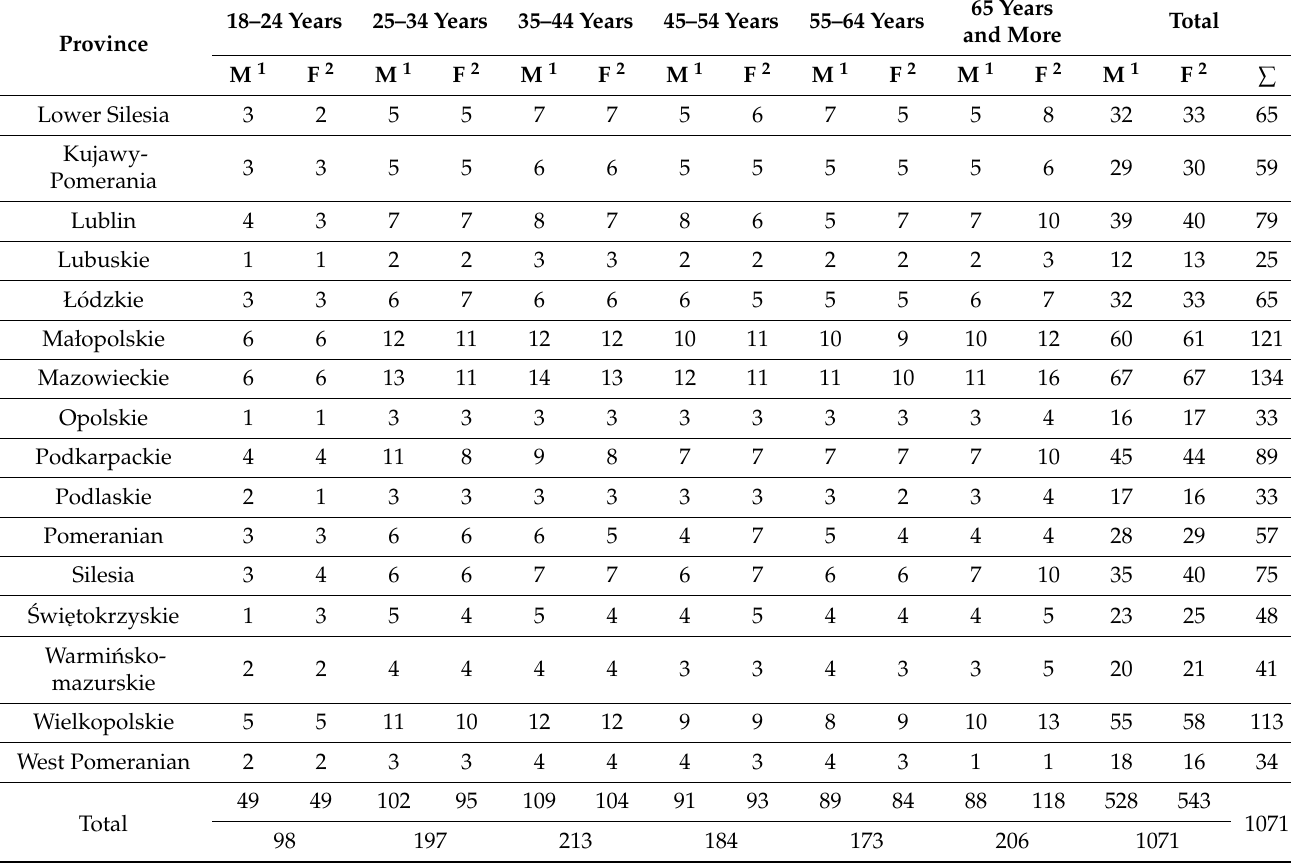
Table 2. Structure of the sample by age group, gender, and province of rural e-customers (own